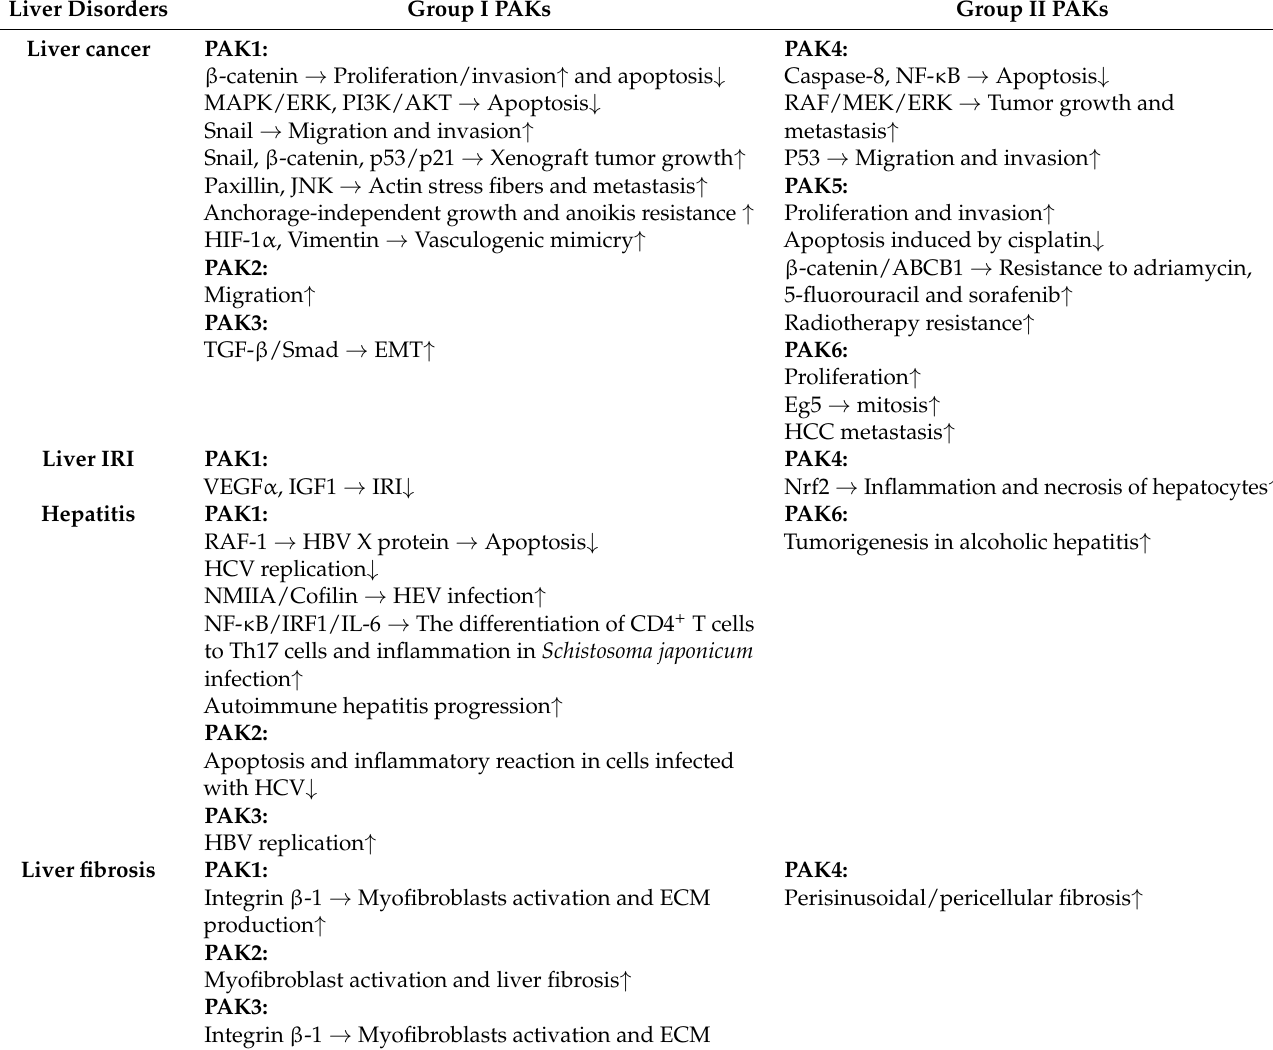
Table 1. Overview of PAKs in liver